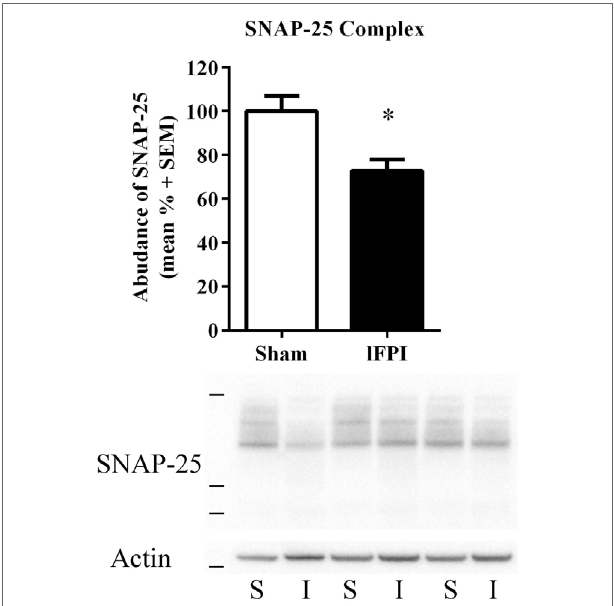
FigUre 5 | Lateral fluid percussion injury (lFPI) reduced soluble N-ethylmaleimide sensitive factor attachment protein receptor complex formation in the hippocampus (SNARE). Representative western blot image of synaptosomal-associated protein of 25 kDa (SNAP-25) immunoreactive SNARE complexes in hippocampal synaptosomal lysates at 1 week post-injury ( n = 3 per group shown). Assessment of high-molecular weight SNARE complexes (markers are 38, 49, and 198 kDa) in lFPI-injured rats (I) revealed significantly reduced abundance compared with sham (S) rats (* p < 0.5) SNAP-25 complexes were normalized to actin (42 kDa, marker is 38 kDa) ( n = 6 sham and n = 6